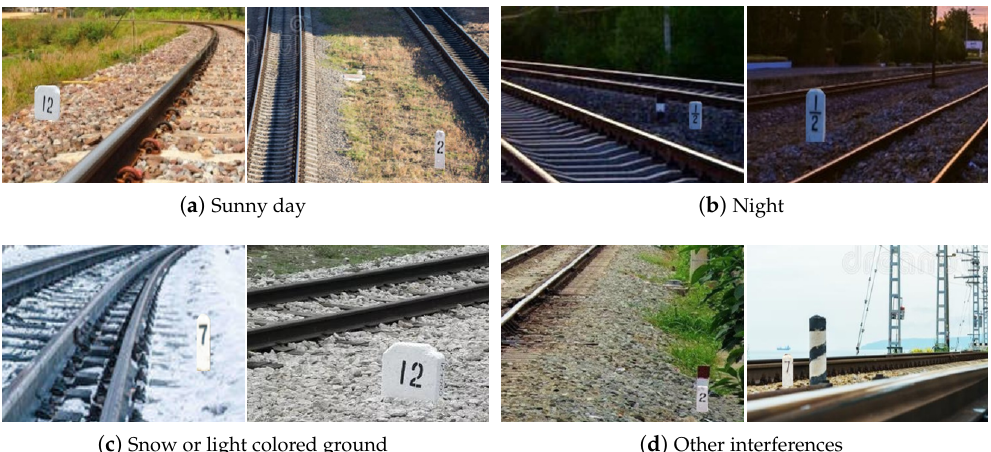
Figure 4. The generated kilometer post